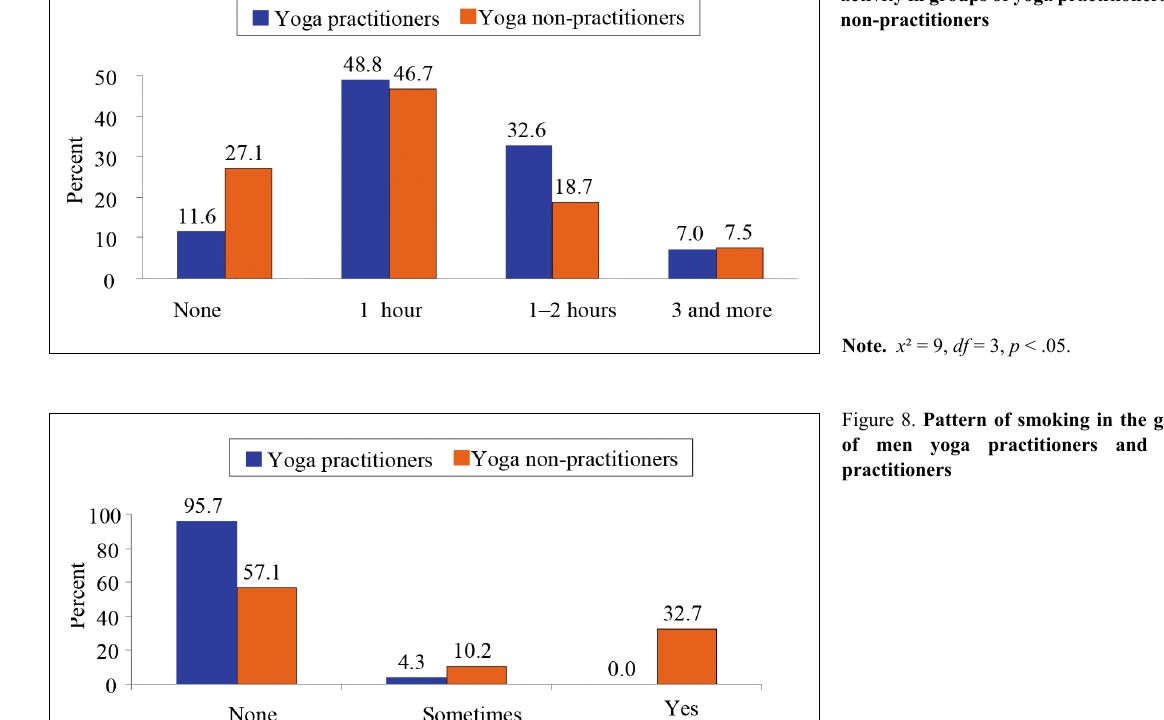
Note. x ² = 16, df = 3, p < .05.